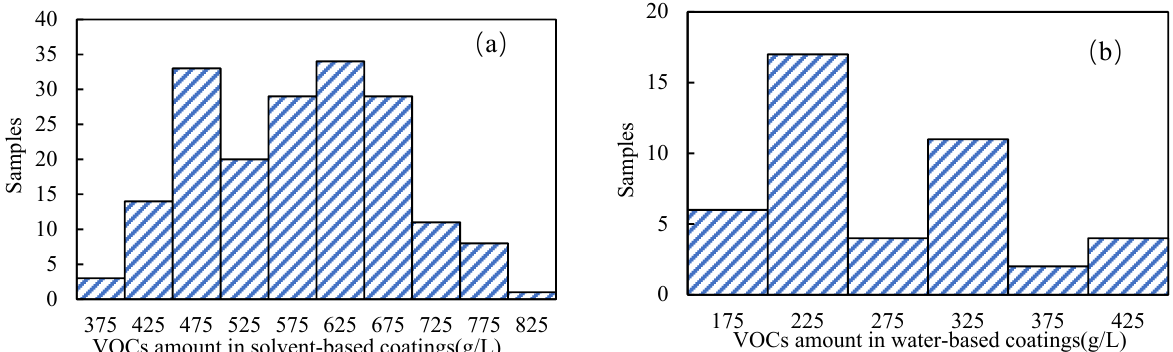
Figure 1. Distribution of VOCs content in solvent-based ( a ) and water-based ( b ) coating samples. Based upon field survey and source sampling, five localized uncontrolled emission factors from the consumption of raw material and product were newly built. Sector-specific